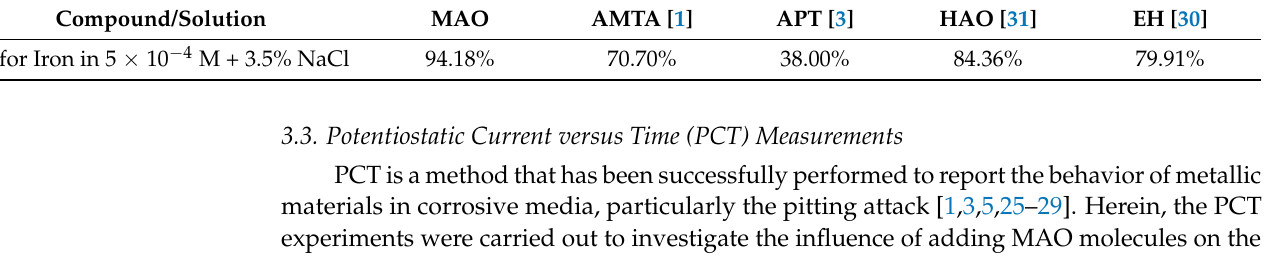
Table 2. Percentage of the inhibition efficiency (IE%) values obtained on the surface of iron after its immersion for 1 h in 3.5% NaCl + 5 × 10 − 4 M of different organic compounds at the same conditions. Compound/Solution MAO AMTA [1] APT [3] HAO [31] EH [30] IE for Iron in 5 × 10 − 4 M + 3.5%